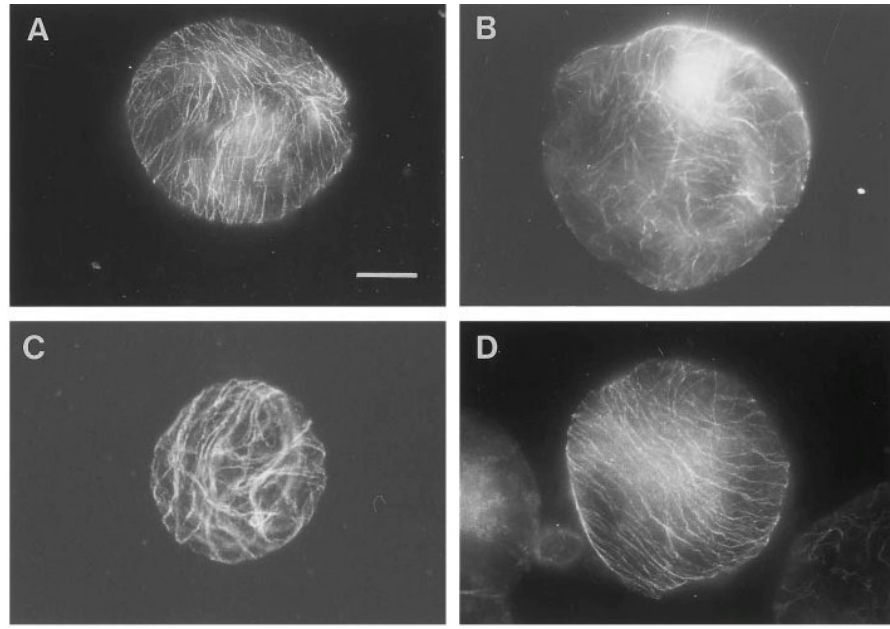
Figure 1. Overview of pattern of corticular microtubules (CMT) in protoplasts exposed to 48 hours of various g-forces. In contrast to most of the protoplasts exposed to 1, 7 or 10 g, which reoriented the CMT in parallel arrays (illustrated by the 1 g- ( A ) and 10 g-protoplast ( D )), the 0 g-protoplasts showed CMT aligned in a random pattern after 48 h of g-treatment ( B ). Protoplasts with partly parallel arrays were observed in all groups, here illustrated by the 7 g-protoplast ( C ). An increased size among the 0 g-protoplasts compared to the 1 g- and hyper-g-protoplasts was observed (bar: 20 mm)—(original picture by Skagen and Iversen